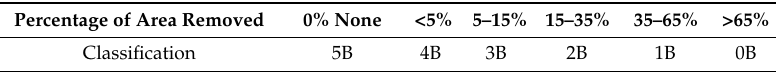
Table 3. Classification of the adhesion